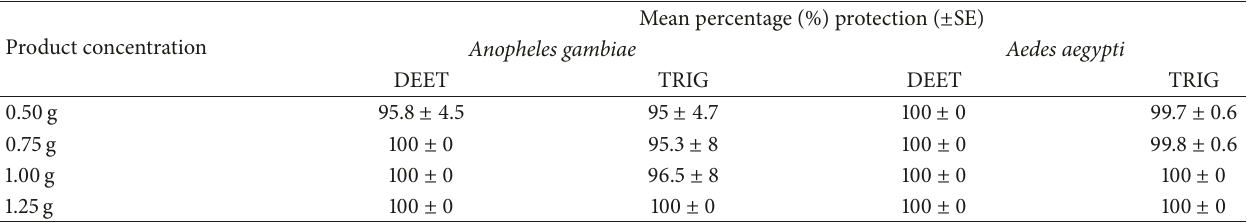
Table 1: Mean percentage protection of different concentrations of DEET and TRIG against An. gambiae and Aedes aegypti mosquitoes in laboratory tests.